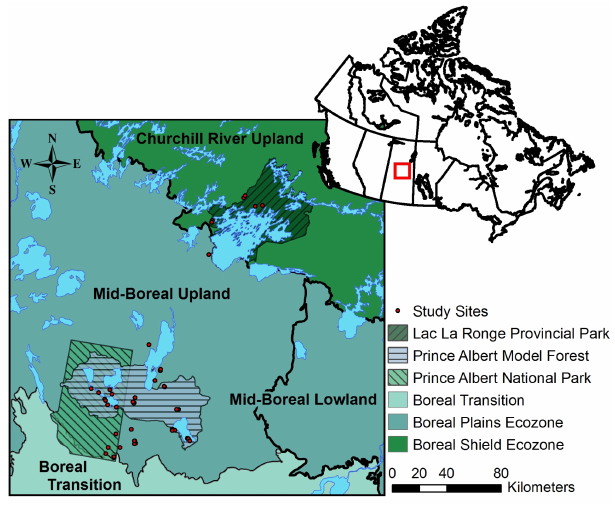
Fig. 1. Location of the study area in the boreal forest of Canada (inset) and locations of forest stands sampled for avian abundance in ~1994 and 2014 in the boreal mixedwood forest of central